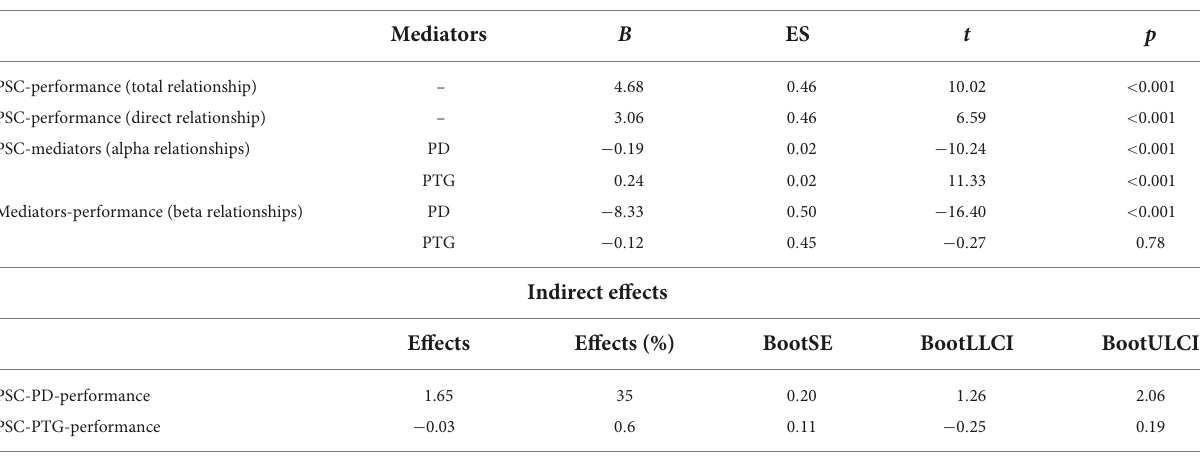
TABLE 3 Results of direct and indirect effects of